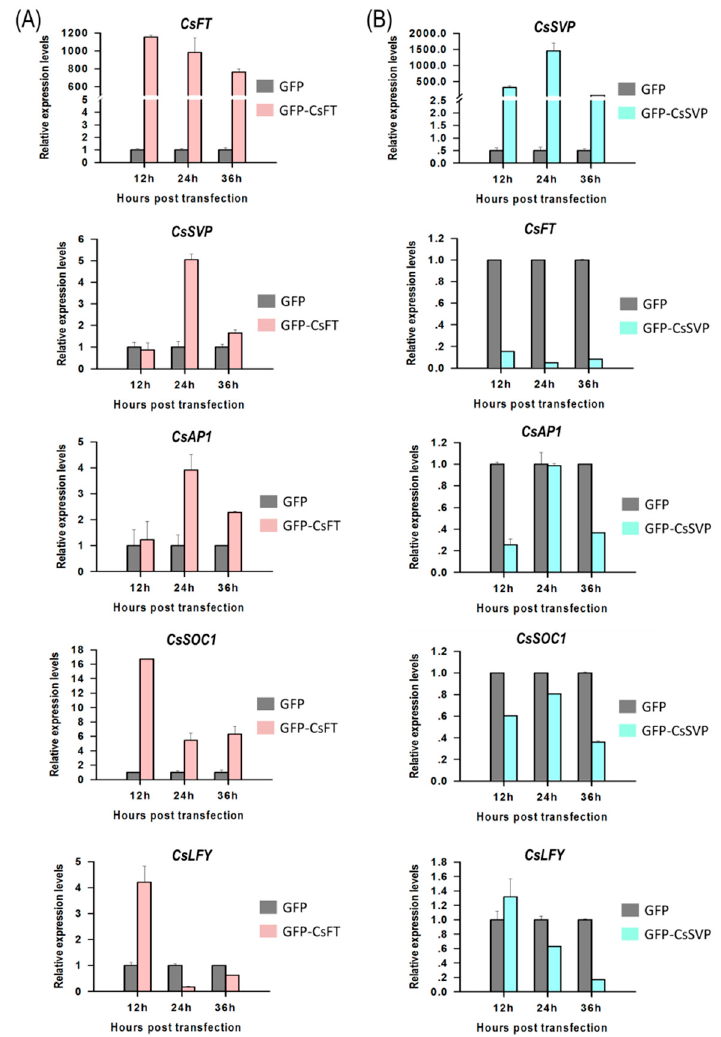
Figure 5. Gene regulation analysis using the PTES and qRT-PCR. ( A ) CsFT was successfully overexpressed in Cymbidium protoplasts using the PTES, which in turn resulted in upregulated expression of CsSOC1 , CsAP1 , CsLFY and CsSVP and ( B ) CsSVP was also successfully overexpressed in Cymbidium protoplasts 12–36 hpt, and the expression levels of CsSOC1 , CsAP1 , CsLFY and CsFT were significantly reduced. Y-axes indicate the relative expression levels of controls and transfected protoplasts at different time points (12, 24 and 36 hpt). Data were expressed as the mean of three biological replicates with error bars indicating the SD.